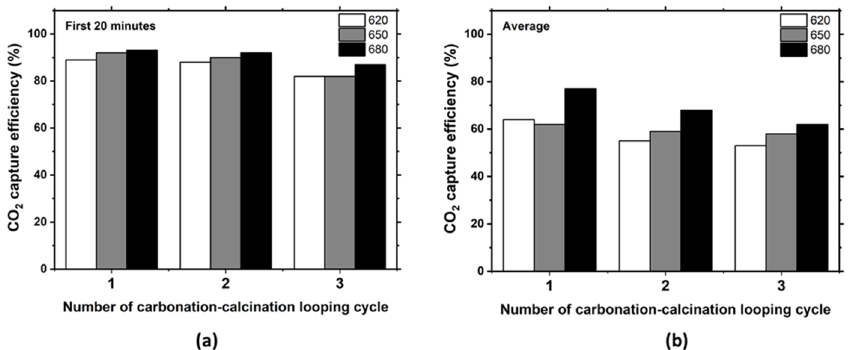
Figure 2. CO 2 capture efficiencies of the sorbent material at three carbonation temperatures from the feeding gas with contamination of H 2 S, NH 3 , and HCl: ( a ) average values in the first 20 min of the carbonation stage, ( b ) average values through the entire carbonation stage.